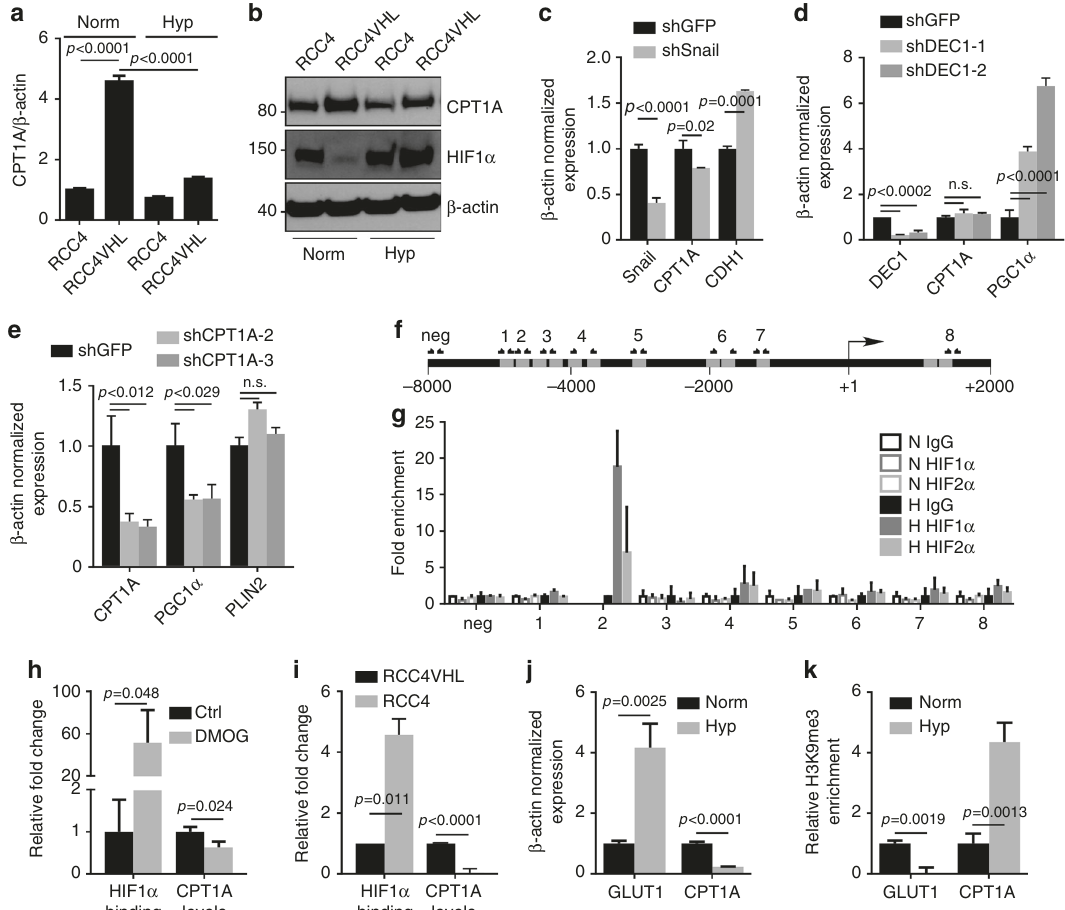
Fig. 5 HIF1 and HIF2 bind CPT1A and inhibit expression. a mRNA expression of CPT1A in RCC4 and RCC4 VHL cells in normoxia or hypoxia as measured by qRTPCR normalized to β -actin. b Western blot depicting protein expression of CPT1A, HIF1 α , and β -actin in RCC4 cells in normoxia or hypoxia for 24 h. c Quanti fi cation of the effect of shRNA knockdown of Snail in RCC4 cells on CPT1A and CDH1 ( E-cadherin ) expression. d Quanti fi cation of the effect of shRNA knockdown of DEC1 with two different shRNAs in RCC4 cells on CPT1A and PGC1 α expression. e Quanti fi cation of the effect of shRNA knockdown of CPT1A in RCC4 cells on PGC1 α and PLIN2 expression. f Diagram of the CPT1A promoter region analyzed for putative HREs (gray boxes) 8000 base pairs upstream to 2000 base pairs downstream of the transcriptional start site (+1). Primer pairs used for PCR ampli fi cation after ChIP are indicated. g qRTPCR results using primers pairs indicated in f of ChIP with antisera to HIF1 α or HIF2 α performed on RCC4 VHL chromatin after treating the cells with normoxia (open boxes) or hypoxia (closed boxes) for 24 h. h HIF1 α ChIP on the CPT1A region 2 HRE in lysates of RCC4 VHL cells treated with DMOG for 36 h ( “ HIF1 α binding ” ) compared with CPT1A RT-PCR ( “ CPT1A levels ” ). i HIF1 α ChIP on the CPT1A region 2 HRE in lysates of normoxic RCC4 and RCC4 VHL cells. j mRNA expression of GLUT1 and CPT1A in RCC4 VHL cells in normoxia or hypoxia as measured by qRTPCR normalized to β -actin. k qRTPCR results of histone H3 lysine 9 trimetylation ChIP on the GLUT1 and CPT1A promoters of RCC4 VHL cells in normoxia or hypoxia. Error bars represent standard deviations. p values of two-tailed Student ’ s t tests are